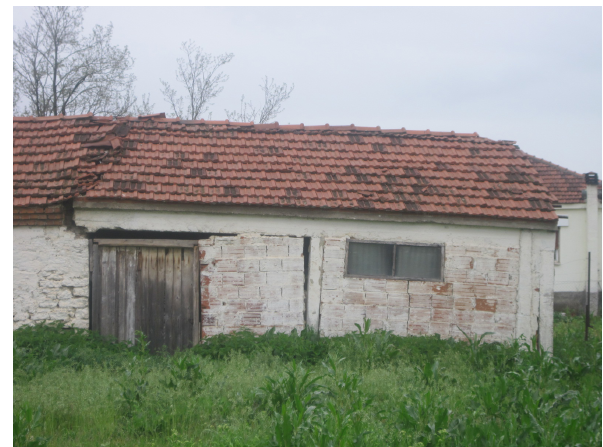
Figure 8. Building damaged by the surface deformations occurring at the Valtonera Village, at the West of the Amyntaio Open Pit Coal Mine, West